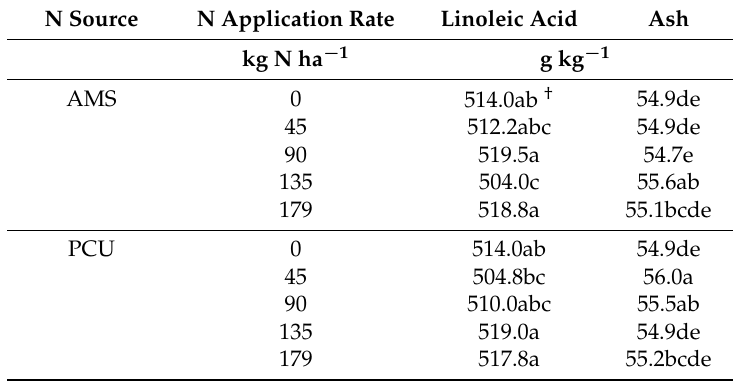
Table 5. Soybean seed linoleic acid and ash concentration as affected by the N source and N rate for study conducted on clay soil in